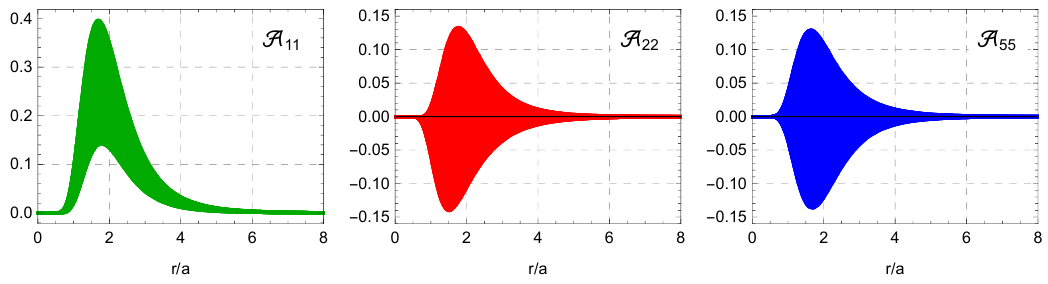
Figure 4 . Plots of envelopes of A 11 (left), A 22 (middle) and A 55 (right), at n = 9 . The curves are √ rescaled by ˜ b 2 ≡ ( b/ 2 a ) 2 and given in units of a 2 . In true scale A ii become large as ˜ b is increased to obtain a long